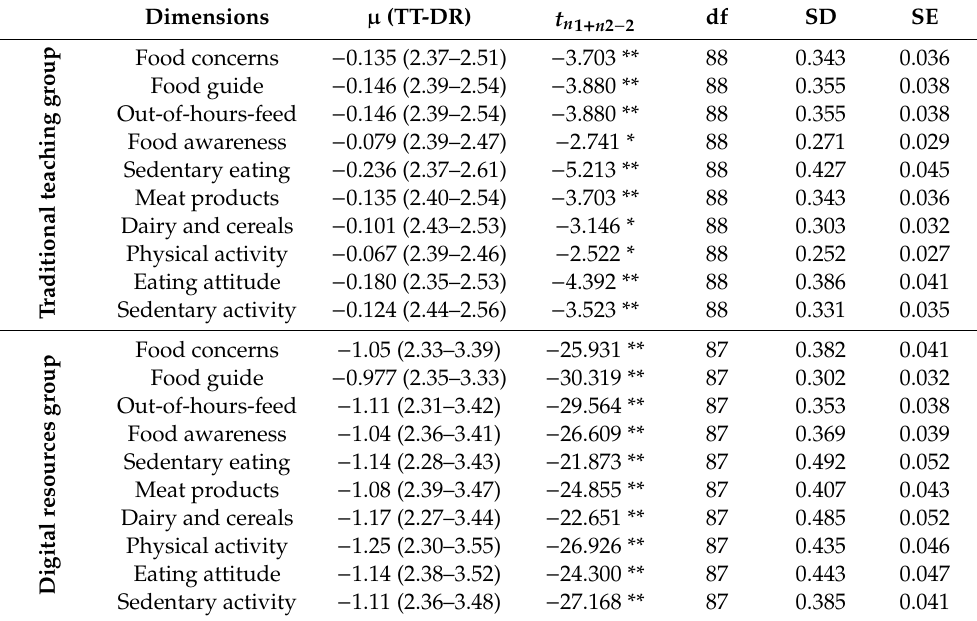
Table 3. Level of dependency between pre-test and post-test within TT and